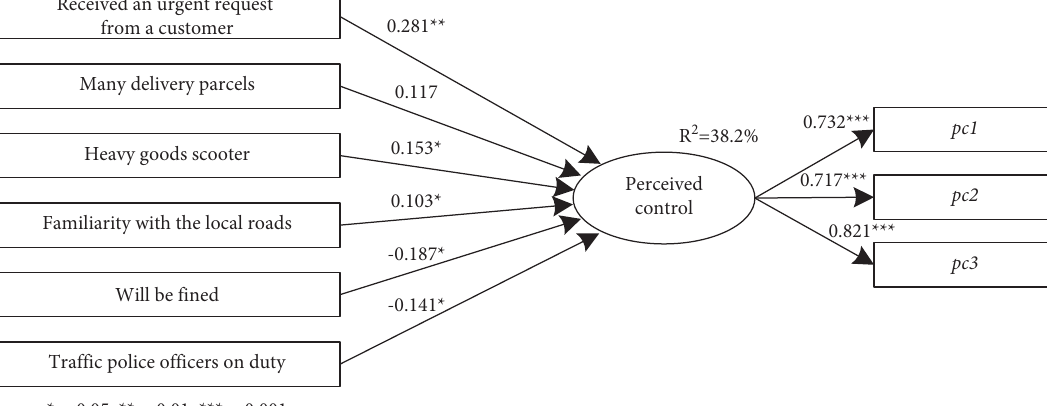
Figure 4: Control factors predicting perceived control.